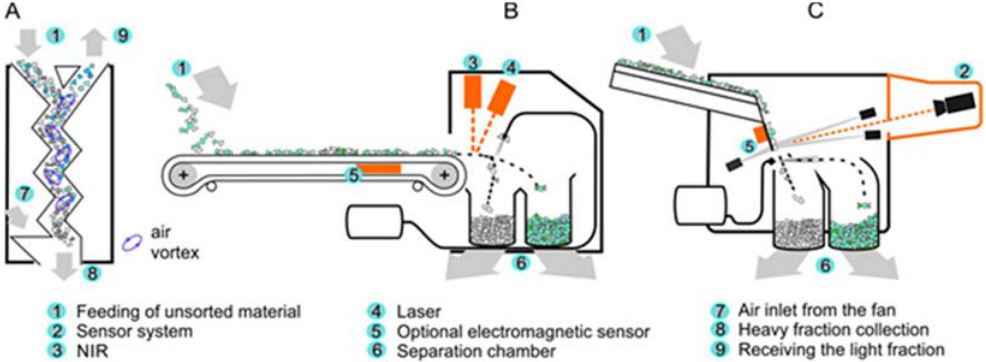
Figure 4. The equipment used in a process developed to recover glass from inert waste fractions using MBT. ( A ) ZIG ZAG air separator, ( B ) TOMRA AUTOSORT LASER separator, ( C )